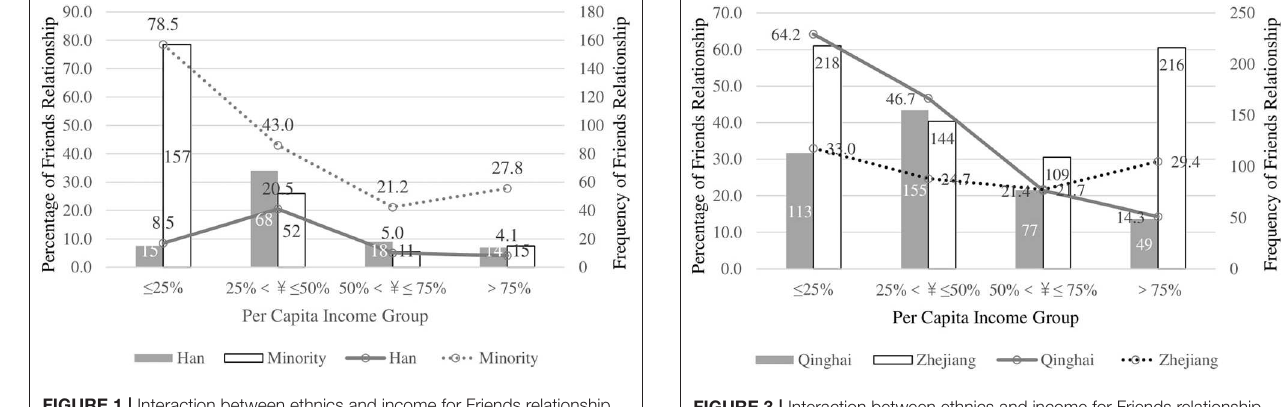
FIGURE 3 | Interaction between ethnics and income for Friends relationship with doctors in Primary Care Institution for Han Chinese.